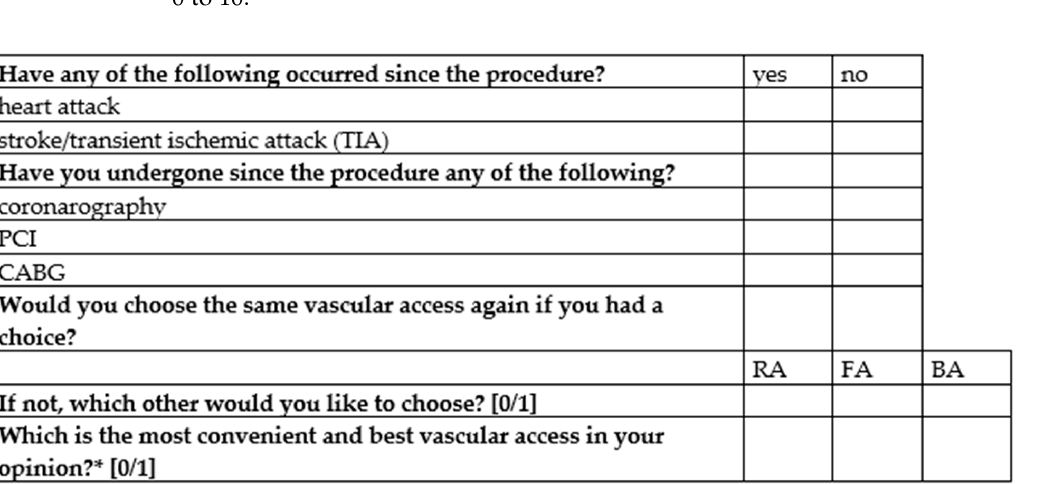
Table 1. Characteristics of patients and procedures.